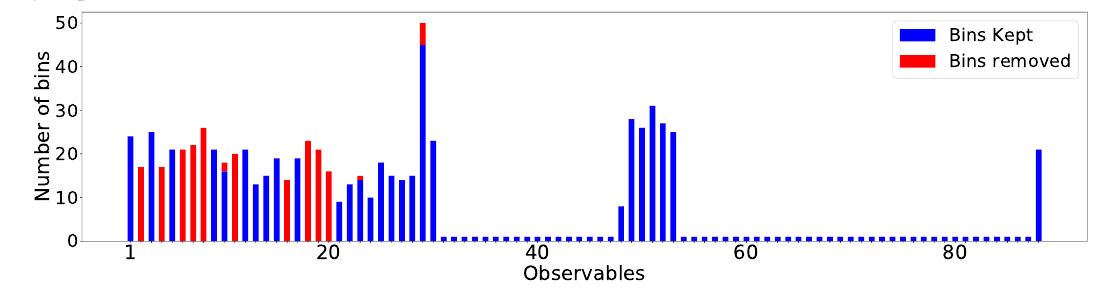
(a) Bins kept and removed by the bin filter in all A14 observables organized by the observable group. Group A is Track jet properties , group B is Jet shapes , group C is Dijet decorr , group D is Multijets , group E is p Z , group F is Substructure , group G is t ¯ t gap , group H is Track-jet UE , group I is t ¯ t jet shapes , and T